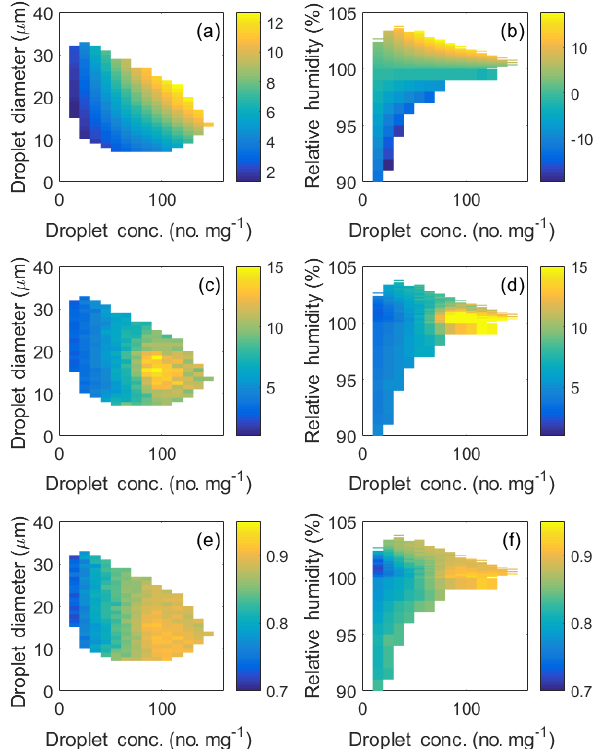
Figure 2. (a, b) Example average condensation and evaporation rates (mgkg − 1 s − 1 ) , (c, d) example average shape parameters, and (e, f) example average values of f NU , BIN in joint bins from BIN400. Panels (a, c, e) show average values of the two quantities for all joint bins from BIN400 with S between 1.011–1.012, and (b, d, f) show averages for all joint bins from BIN400 with D between 19 and 20µm.